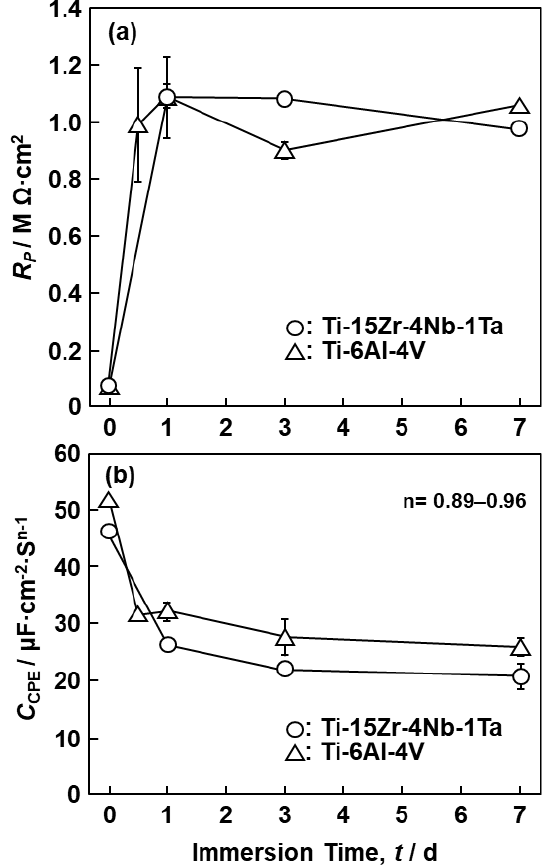
Figure 10. ( a ) Resistance of oxide film (R P ) and ( b ) constant-phase element (capacitance) of oxide film (C CPE ) formed on surfaces of Ti–15Zr–4Nb–1Ta and Ti–6Al–4V alloys after different immersion times in 0.9% NaCl solution at 37 °C.